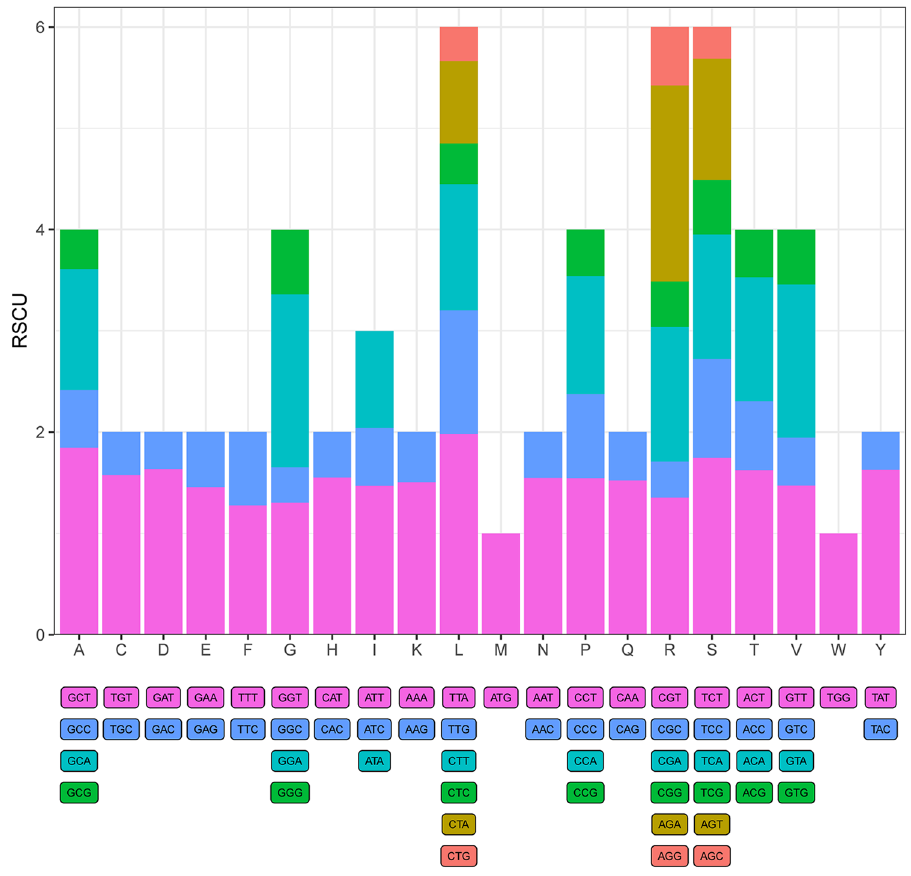
Figure 4. The values of relative synonymous codon usage (RSCU) of Allium mongolicum